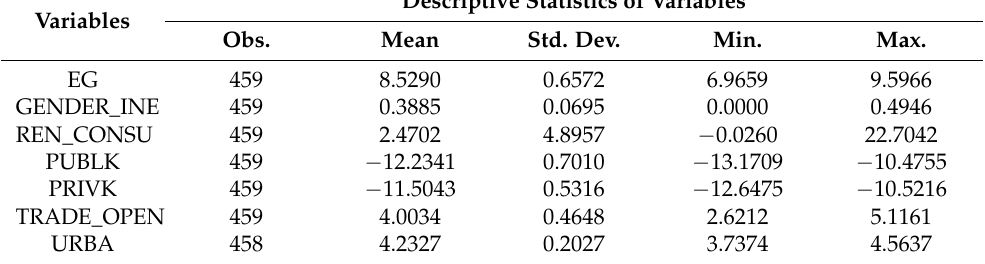
Table 3. Descriptive statistics.